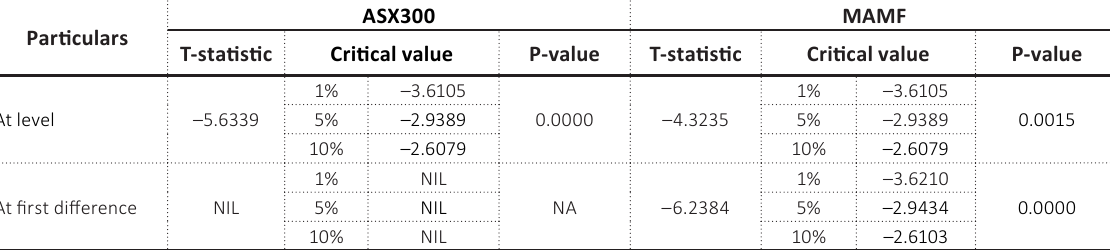
Table 4. ADF test – ASX300 and MAMF